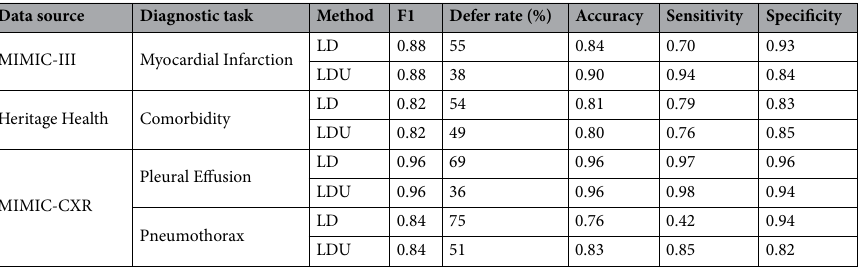
Table 2. Comparison of accuracy, sensitivity, and specificity between the LDU algorithm and learning to defer without uncertainty (LD) for selected F1 scores, across all diagnostic